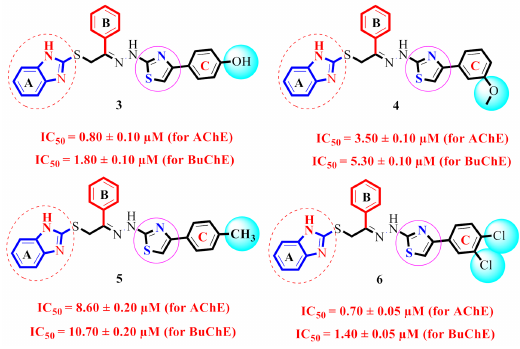
Figure 6. SAR study of scaffolds 3–6 . Analogue 11 (dichloro group at meta - and para -positions on ring C , IC 50 = 0.40 ± 0.050 µ M C , IC 50 = 2.90 ± 0.10 µ M and 3.50 ± 0.10 µ M) and 8 (nitro group at meta position on ring C ,